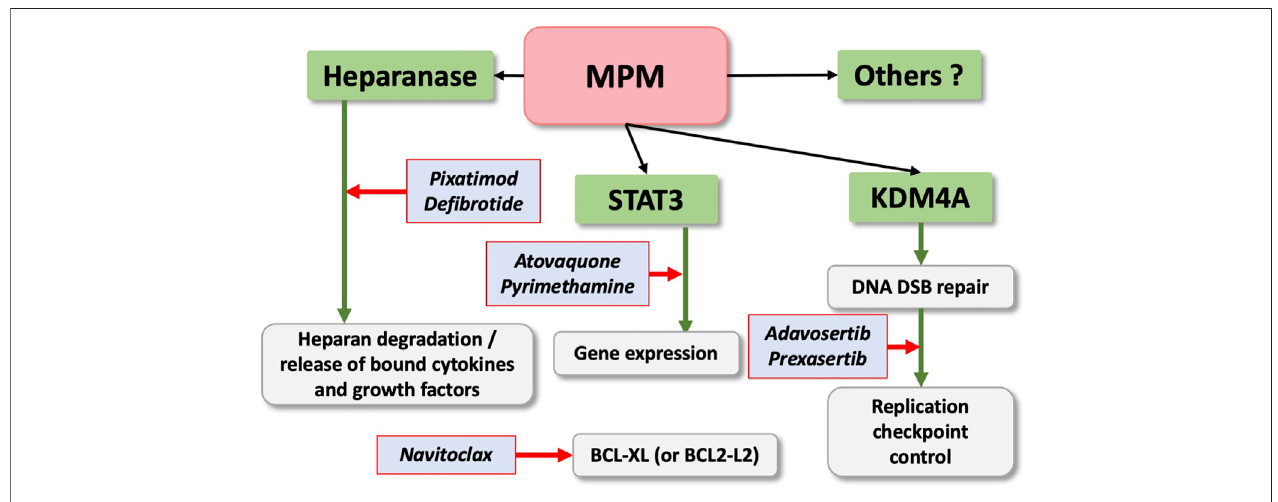
FIGURE 3 | Emerging Therapeutics Targets in MPM. STAT3, KDM4A, heparanase are promising new thereapeutic targets in MPM. Clinical stage inhibitors are indicated and treatment may bene fi t from combination with navitoclax.